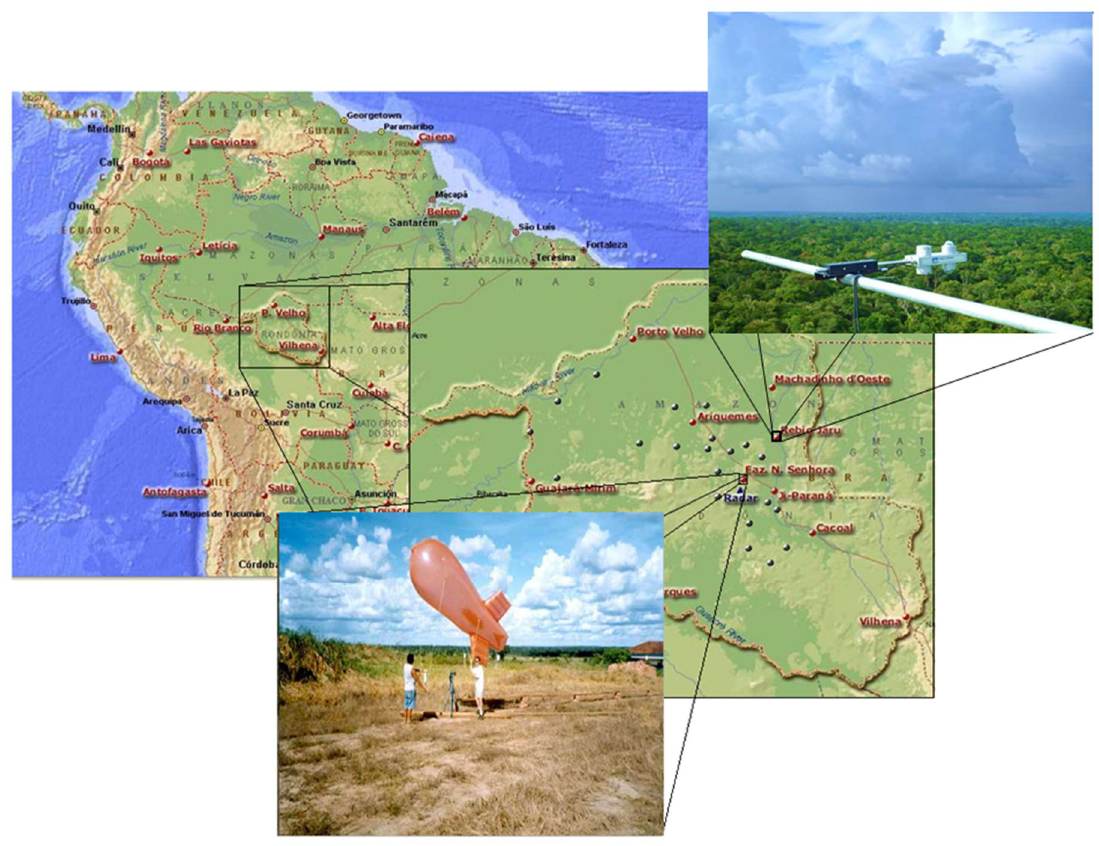
Figure 1. Location of experimental sites. Source: http://www.lba.iag.usp.br.